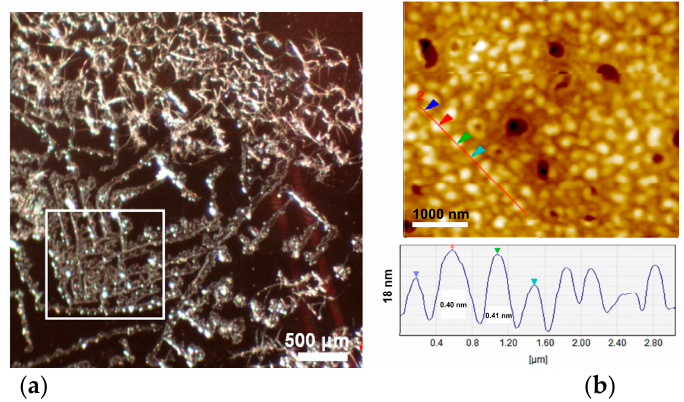
Figure 8. ( a ) Reflected light micrographs and ( b ) atomic force microscopy image and cross-section of LPSQ-amide75-Py crystals. AFM image shows the top of a typical crystal surface in the area marked with the white frame.